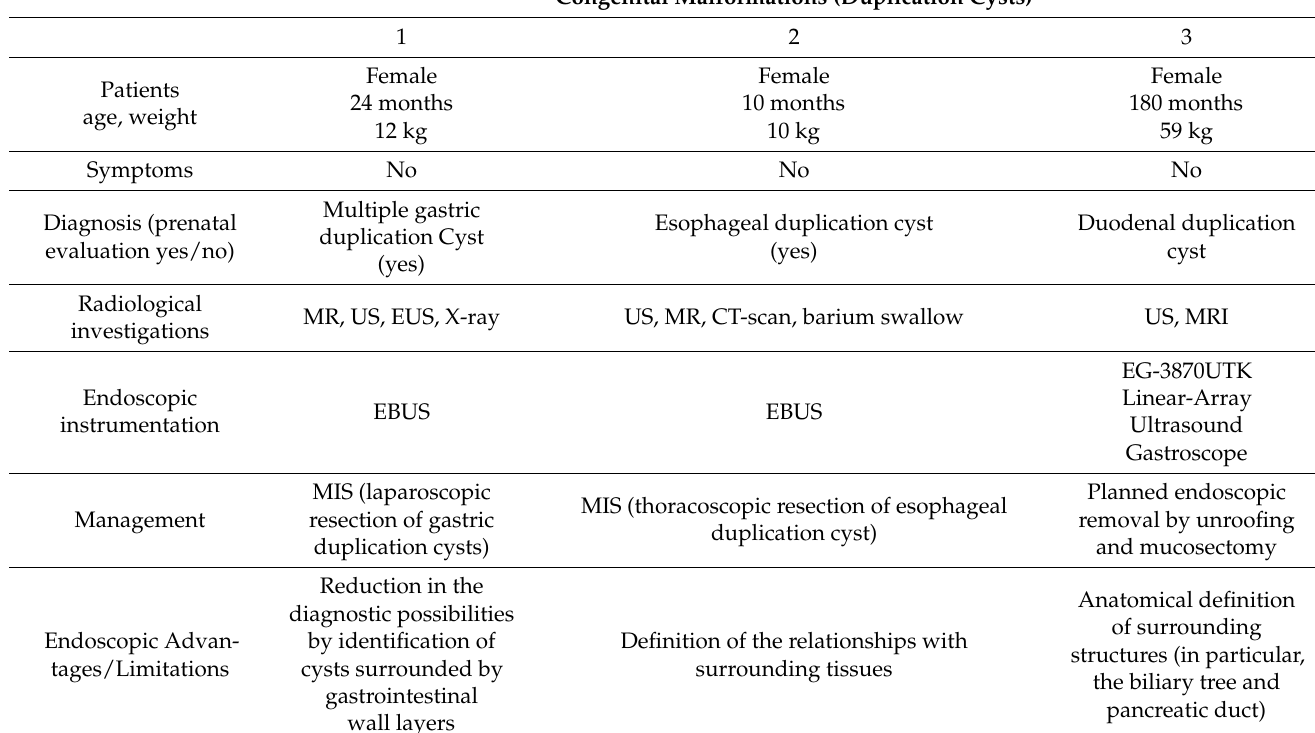
Table 1. Data of patients, endoscopic and surgical details. EBUS endobronchial ultrasound; US ultrasounds; CT computed tomography; ERCP endoscopic retrograde